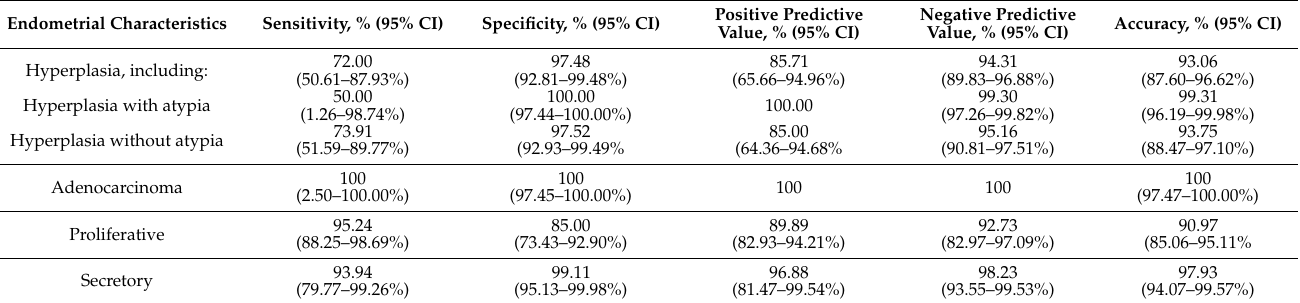
Table 3. Analysis of overall Pipelle biopsy reliability.